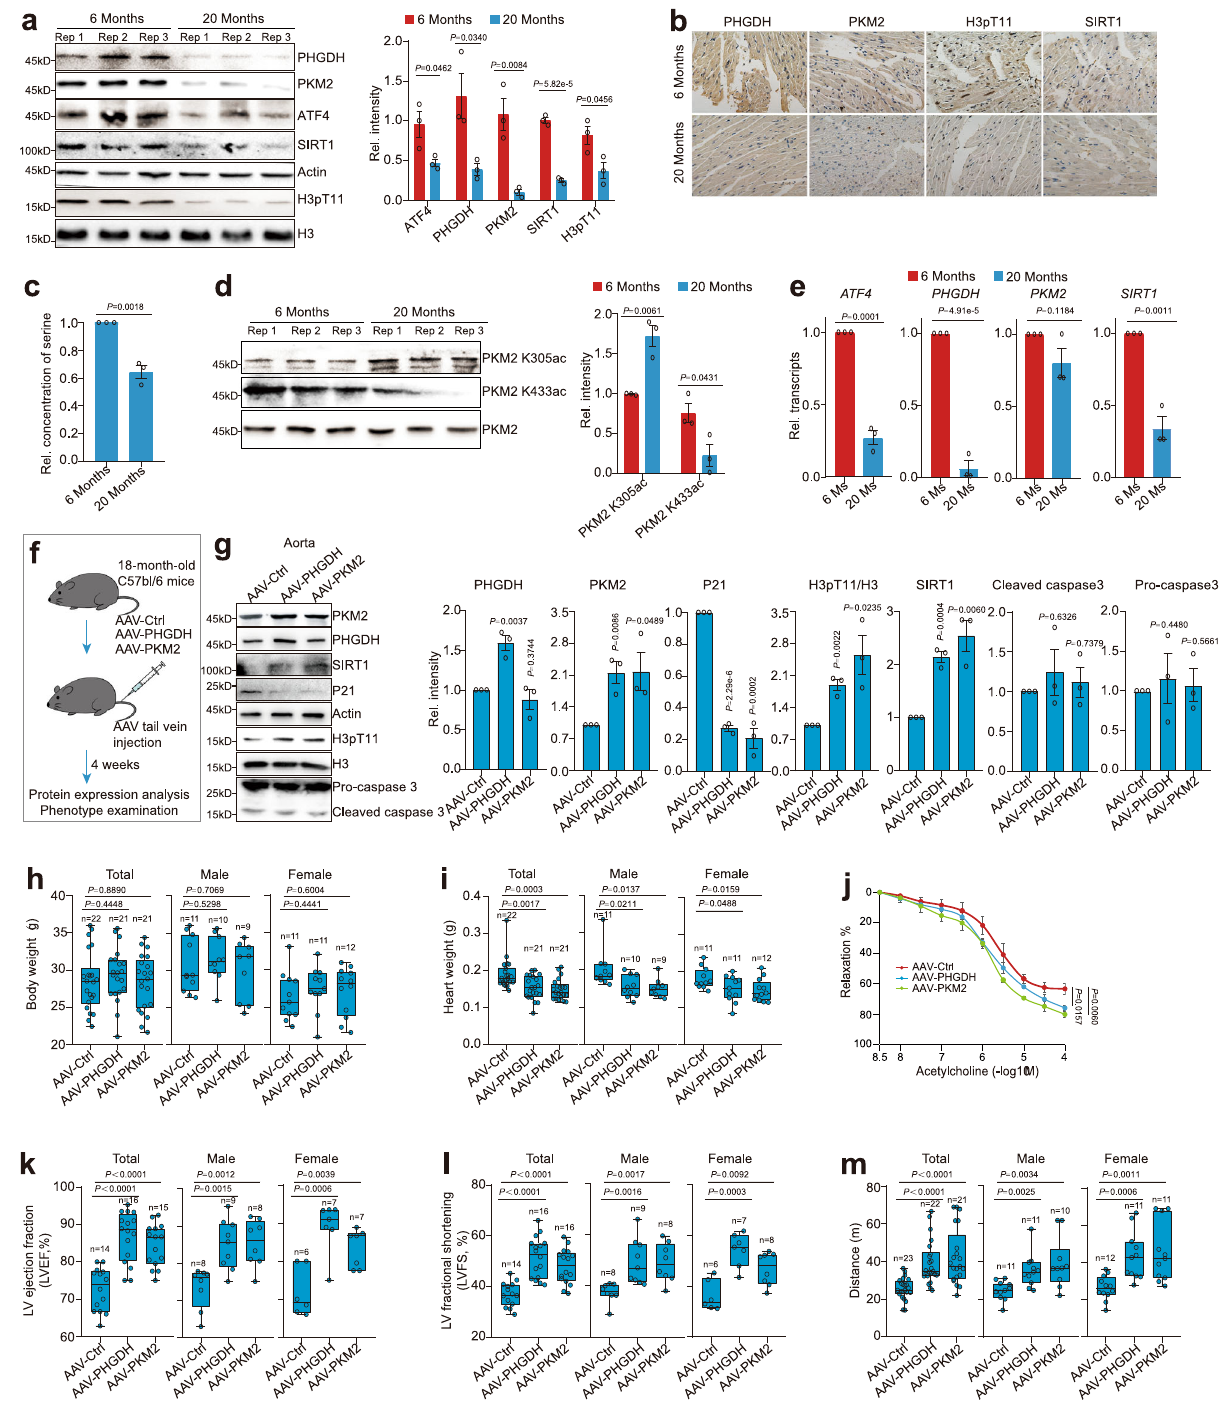
Fig.7|PHGDHandPKM2regulateagingphenotypesinmice.a Immunoblotsof ATF4,PHGDH,PKM2,SIRT1andH3pT11intheheartsofyoungmice(6Months)and aged mice (20 Months). b Representative immunohistochemical staining of PHGDH,PKM2,H3pT11andSIRT1inthe heartsof youngmice(6Months)and aged mice (20 Months). c Analysis of the relative serine concentrations in the hearts of young mice (6 Months) and aged mice (20 Months). d Immunoblots of PKM2 K305ac and PKM2 K433ac in the hearts of young mice (6 Months) and aged mice (20 Months). e RT-qPCR analysis of ATF4 , PHGDH , PKM2 and SIRT1 transcription in the hearts of young mice (6 Months) and aged mice (20 Months). f 18-month-old C57BL/6 mice were injected with AAV that vascular endothelium (VE)-speci fi c expression of PHGDH and PKM2 via tail vein. Four weeks later, protein expression was analyzed and the associated ageing phenotype was examined. g Immunoblots of PKM2,PHGDH, SIRT1, p21 and H3pT11 in theaorta of AAV-Ctrl, AAV-PHGDH and